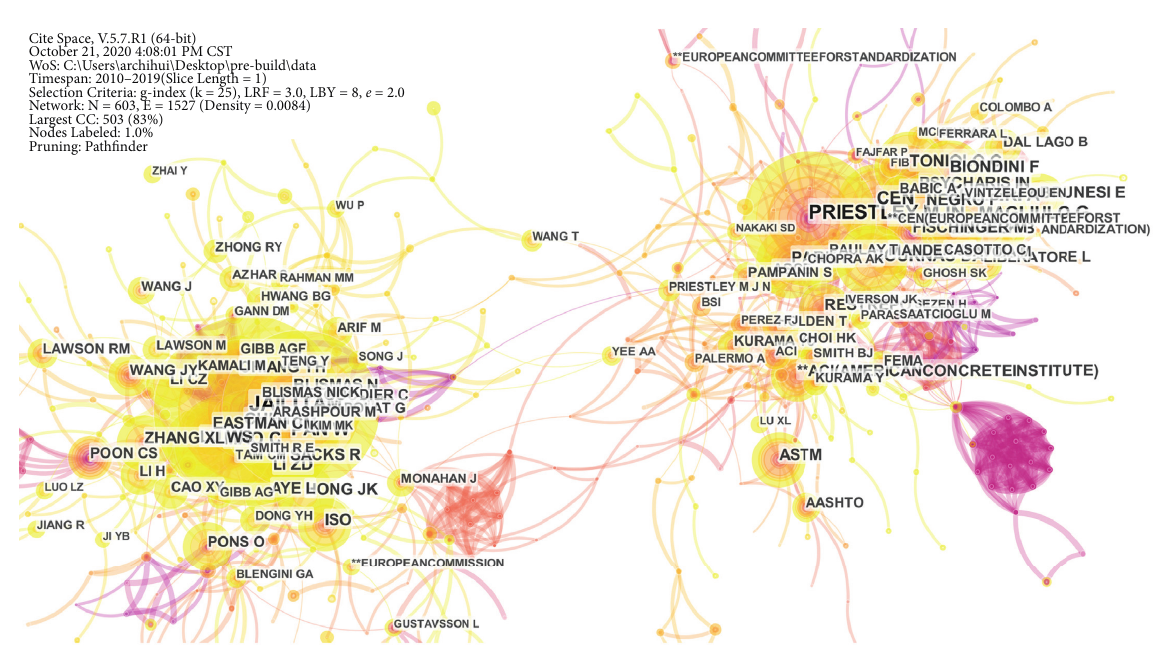
Figure 7: Network of author